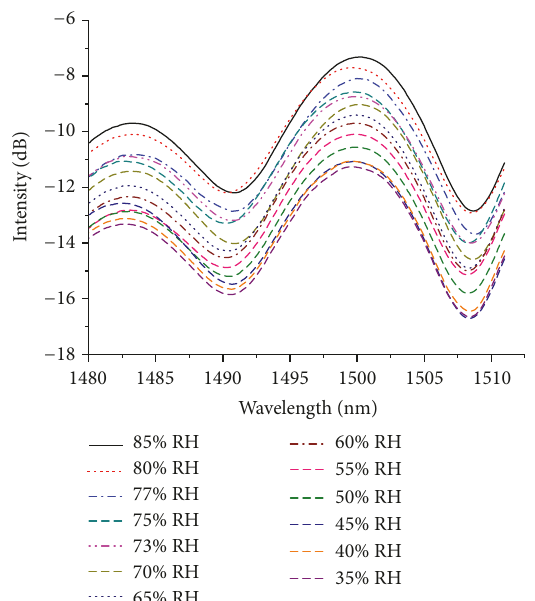
Figure 5: The interference spectrum with the change of humidity in the external environment sensor.